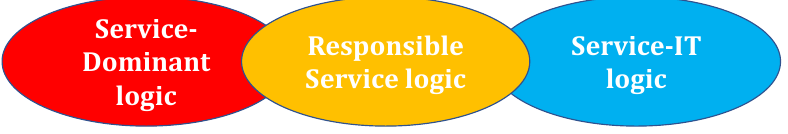
Figure 1. Cognitive continuum between Service-Dominant logic, Responsible Service logic, and Service-IT